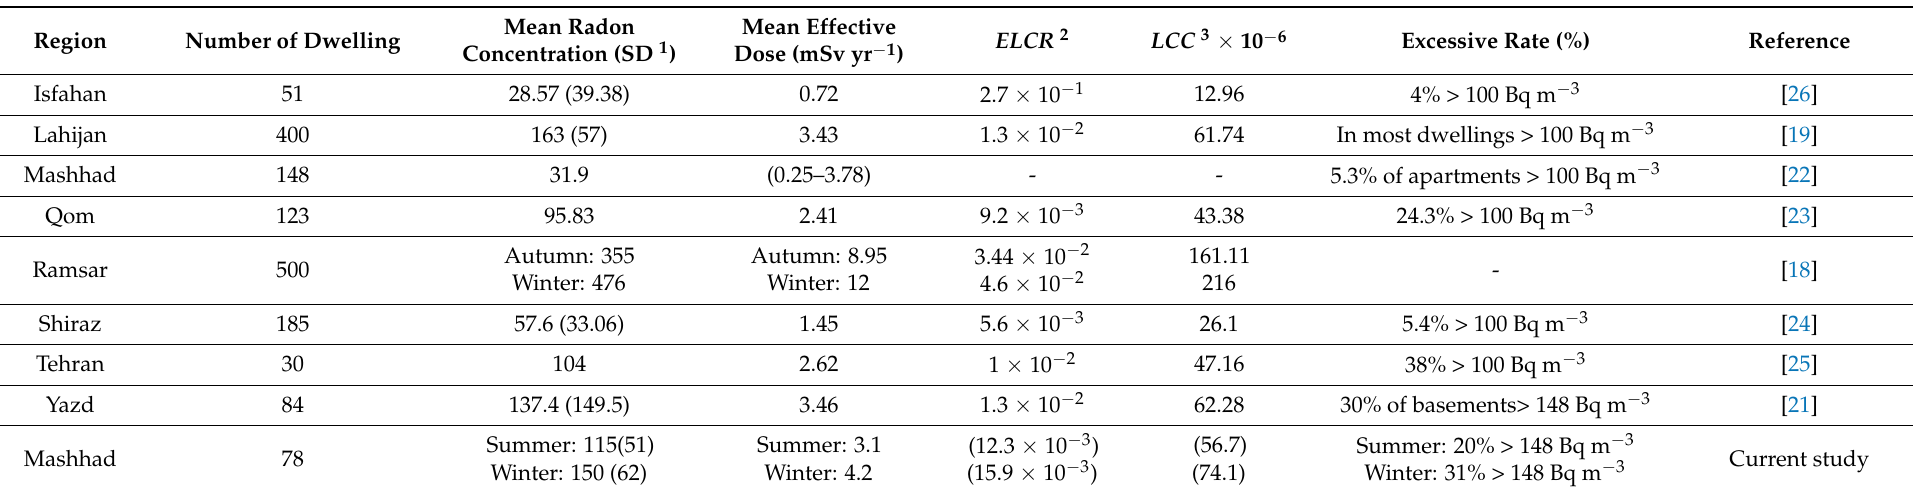
Table 3. Studies on indoor radon concentration (Bq m − 3 ) and radiation health risk in various Iranian